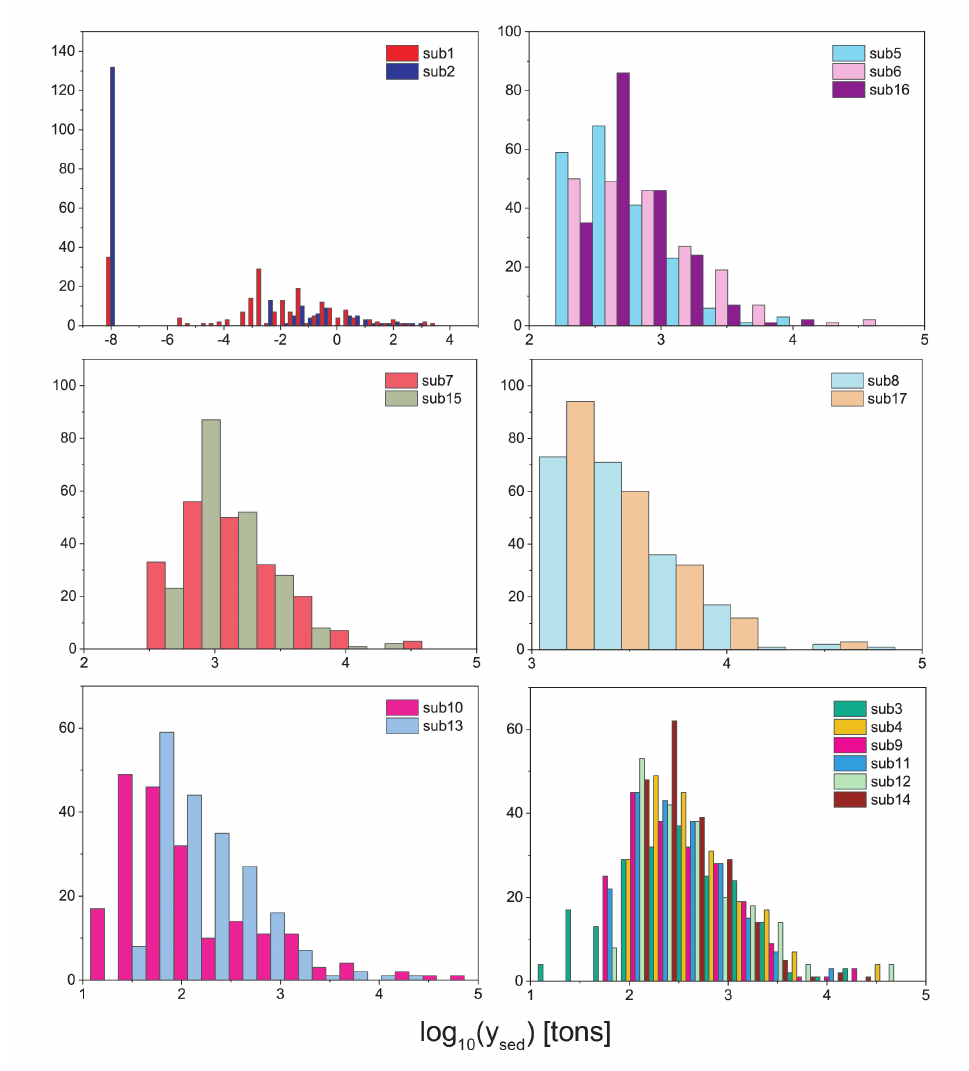
Figure 10. Histogram of the highest fifth percentile of the daily values of y sed of the reference channel of each